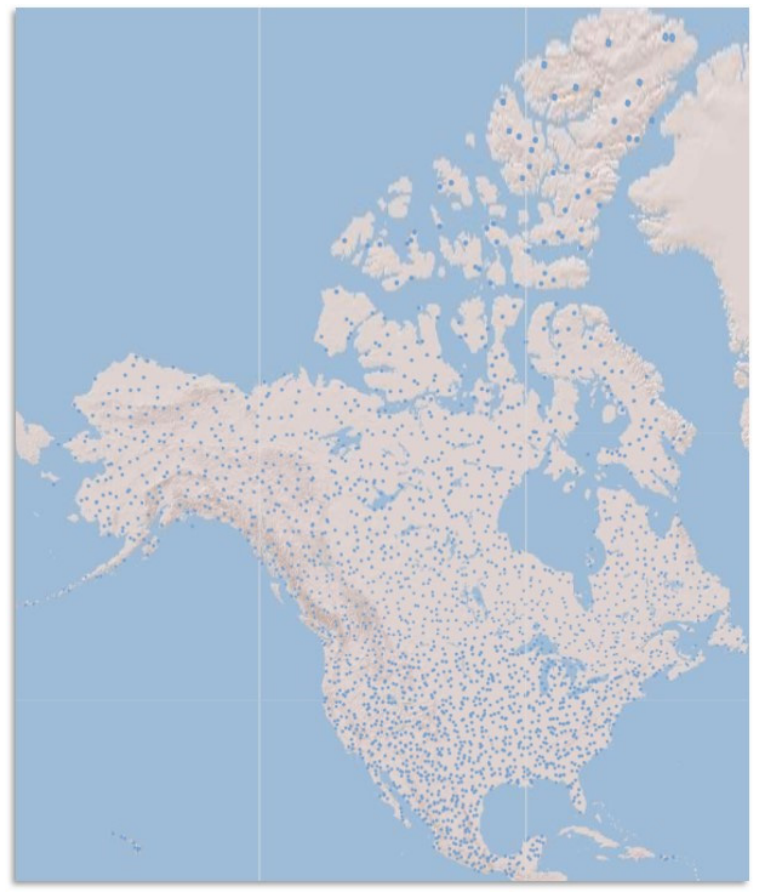
Figure 3. The top 1% priority grid cells from the NABat sampling frame are represented in blue and total 2275 cells across North America. Map is adapted from the North American Bat Monitoring Program Partner Portal [26].